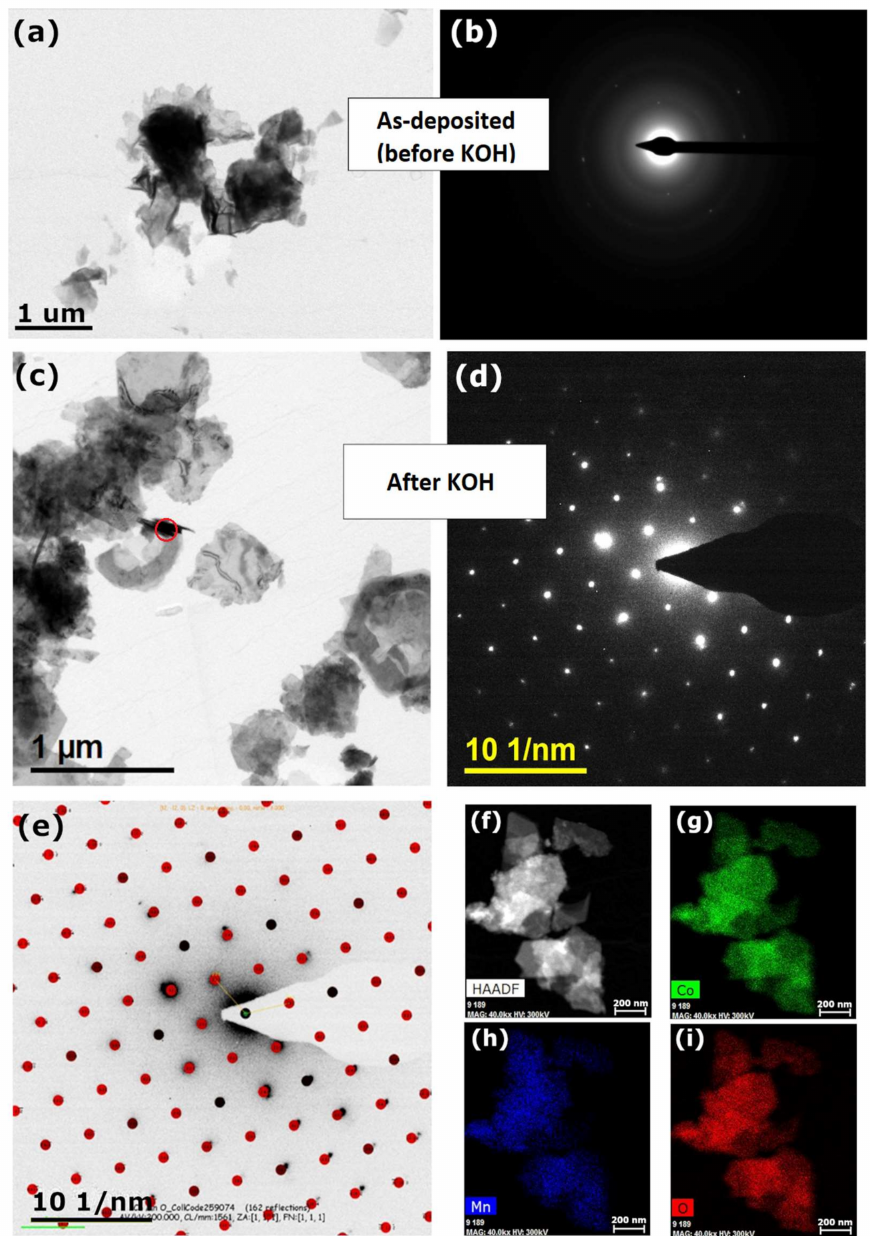
Figure 3. ( a ) Bright Field (BF) TEM image, and ( b ) corresponding experimental Selected Area Di ff raction (SAED) pattern of Mn-Co film before alkaline treatment; ( c ) BF-TEM image, area of SAED pattern is marked with red circle, and ( d ) corresponding experimental SAED pattern from the area, marked on a BF-TEM image with a red circle, of Mn-Co film after alkaline treatment; ( e ) Experimental SAED pattern of area marked with a red circle, superimposed with simulated, theoretical di ff ractogram from cobalt manganese (IV / VI) oxide (0.25 / 1.75 / 4), (259073-ICSD) Zone Axis [111]; ( f – i ) TEM elemental mapping images of ( g ) cobalt, ( h ) manganese, and ( i ) oxygen of the Mn-Co film. Mn-Co film for TEM analysis was synthesised in an aqueous solution of Mn / Co 2 mM / 8 mM (200